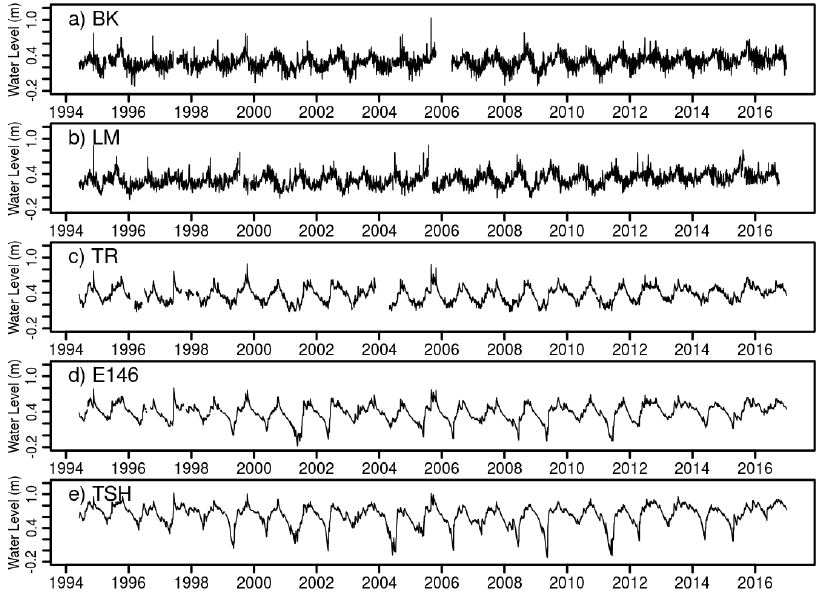
Figure 3. Daily mean water level with respect to the National Geodetic Vertical Datum of 1929 (NGVD29) at 5 stations in Florida Bay and the southern Everglades. Stations BK ( a ) and LM ( b ) are in Florida Bay; stations TR ( c ), E146 ( d ) and TSH ( e ) are within Taylor Slough.